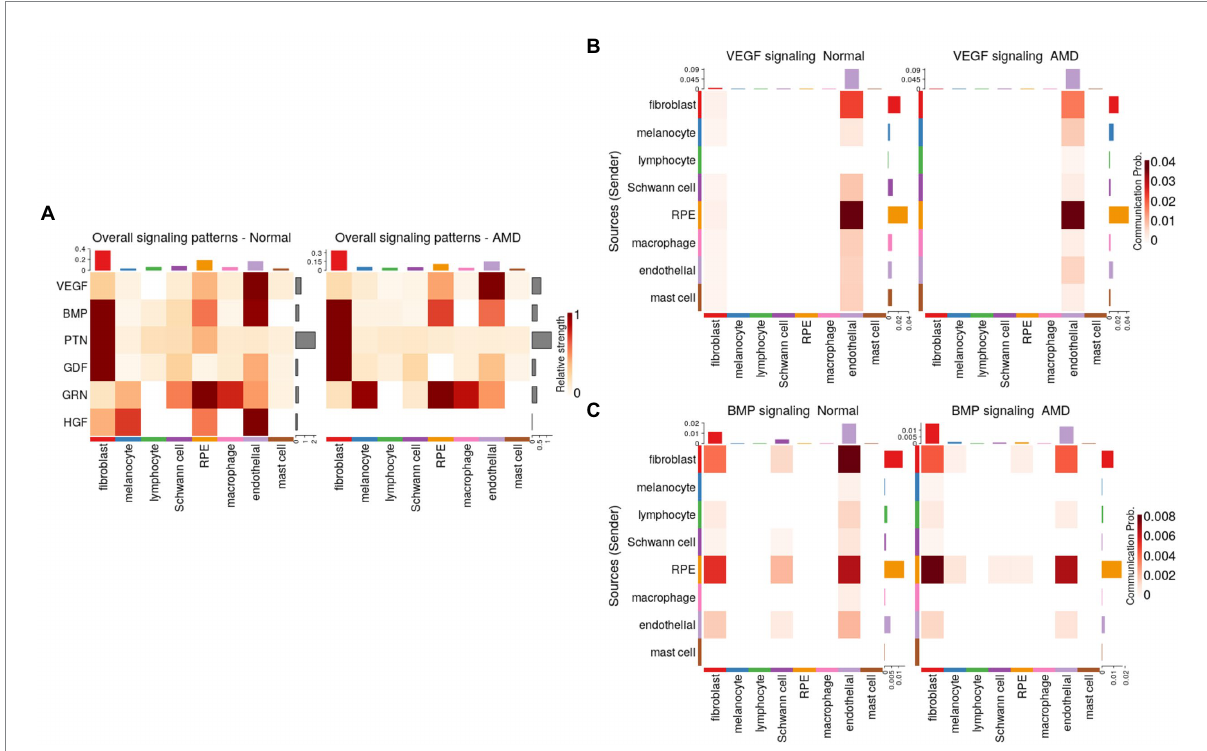
FIGURE 2 Secreted proteins-mediated signaling involving RPE cells derived from CellChat results. (A) Heatmap showing the relative strength of selected signaling pathways across cell types in both normal and AMD tissues in the scRNA-seq dataset from Voigt et al. (2019). Pathways were selected as those being the most relevant to communication patterns involving RPE cells. (B) Cell-type to cell-type heatmap of CellChat communication probabilities aggregated from each VEGF LRI. VEGF signaling was predominantly targeting endothelial cells and was especially elevated when originating from RPE cells. (C) Cell-type to cell-type heatmap of CellChat communication probabilities aggregated from each BMP LRI. BMP signaling was predominantly targeting fibroblasts and endothelial cells and was especially elevated when originating from RPE cells and